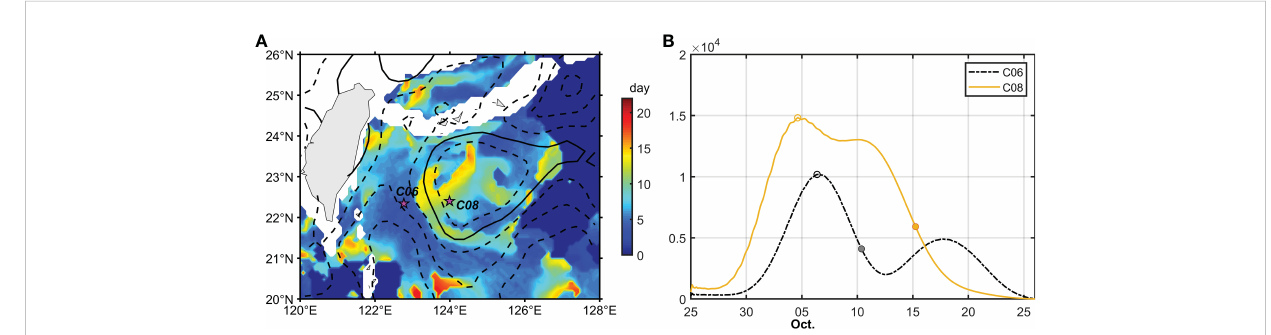
FIGURE 7 Distribution of e-folding time of depth-integrated NIKE east of Taiwan (A) . Superimposed black line is the time-averaged (from 30 September to 24 October) SLA contours with an interval as Figure 5. Pink stars represent the locations of moorings. Time evolution of depth-integrated NIKE at different points (B) (unit: J/m 2 ). The fi lled and empty circles represent the maximum and e-folding values of depth-integrated